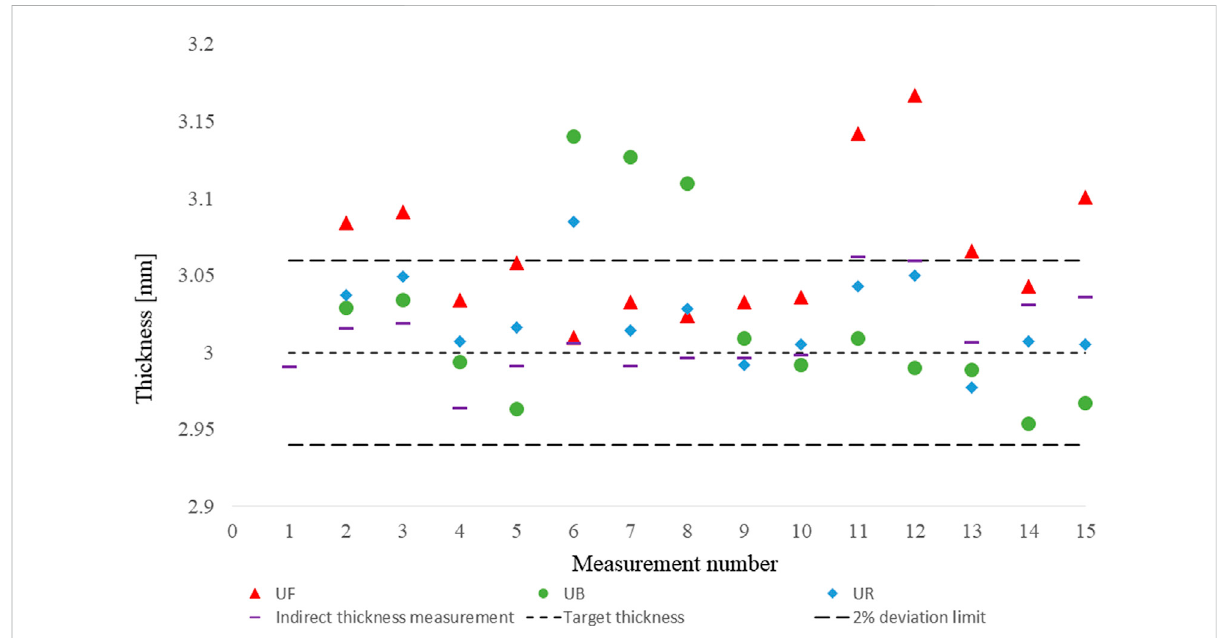
FIGURE 10 Recorded thicknesses during tests. UF(front), UR (right), and UB(back) are measured by the three laser sensors. The positions refer to the sensor ’ s location above the compaction plate. The indirect thickness measurement method uses the displacement measured by the Instron to calculate the distance between plates. The dashed lines represent the target thickness and the 2% deviation